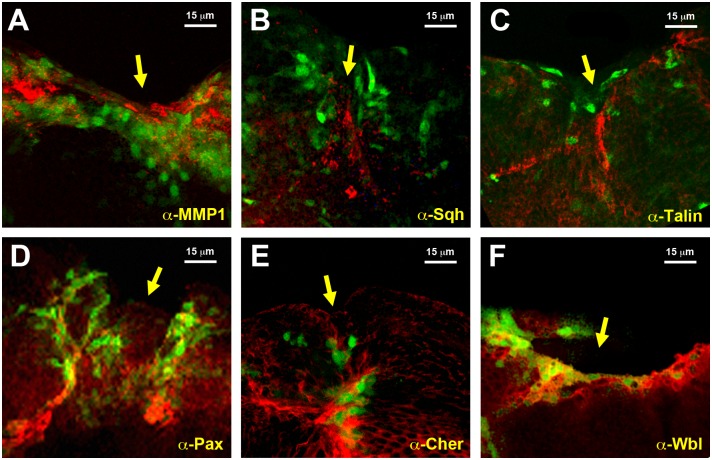
Validation of the genomic expression analysis.
A) Imaginal disc, 12 hours after incisive wounding, showing enhanced expression of MMP1, a secreted matrix metalloproteinase upregulated in the healing transcriptome, in those cells engaged in healing (red). Similar results were observed for B) Spaghetti squash, the homologue of the regulatory light chain of non-muscle myosin II; C) Talin, a FERM domain protein linking the cytoplasmic tail of integrins to the actin cytoskeleton; D) Paxillin, a cytoskeleton scaffolding protein present at focal adhesions; E) Cheerio coding for filamin, an actin binding protein; and F) Windbeutel, a resident protein of the endoplasmic reticulum. All these genes were found to be upregulated in the healing transcriptome. GFP expression highlighting puc upregulation in all cases is shown in green. Scale bars are indicated for each panel.